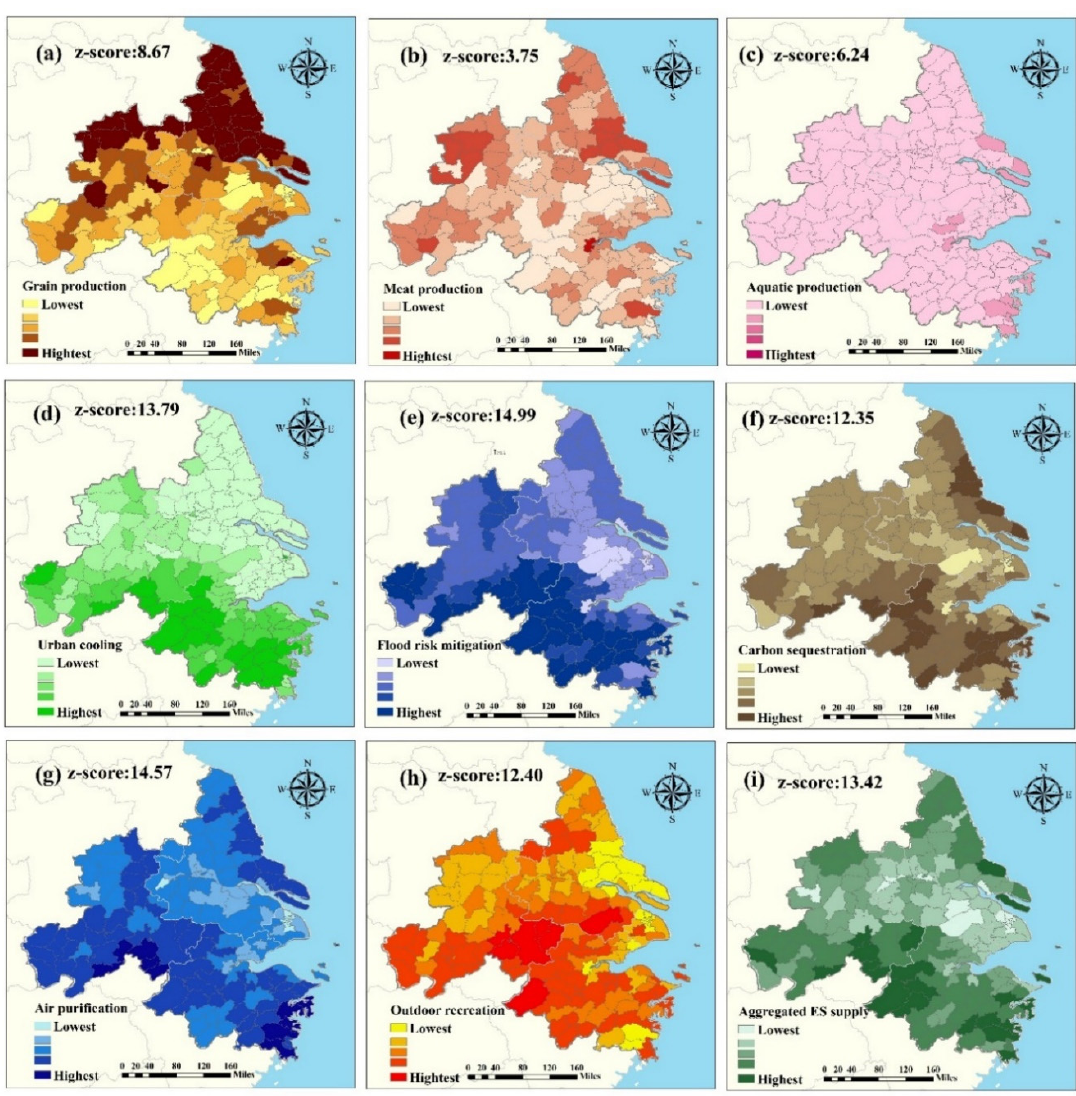
Figure 3. The spatial distributions of individual ES supply indicators ( a – h ) and aggregated ES supply capacity (i). The z-score values in each panel indicate the significance of spatial autocorrelation.